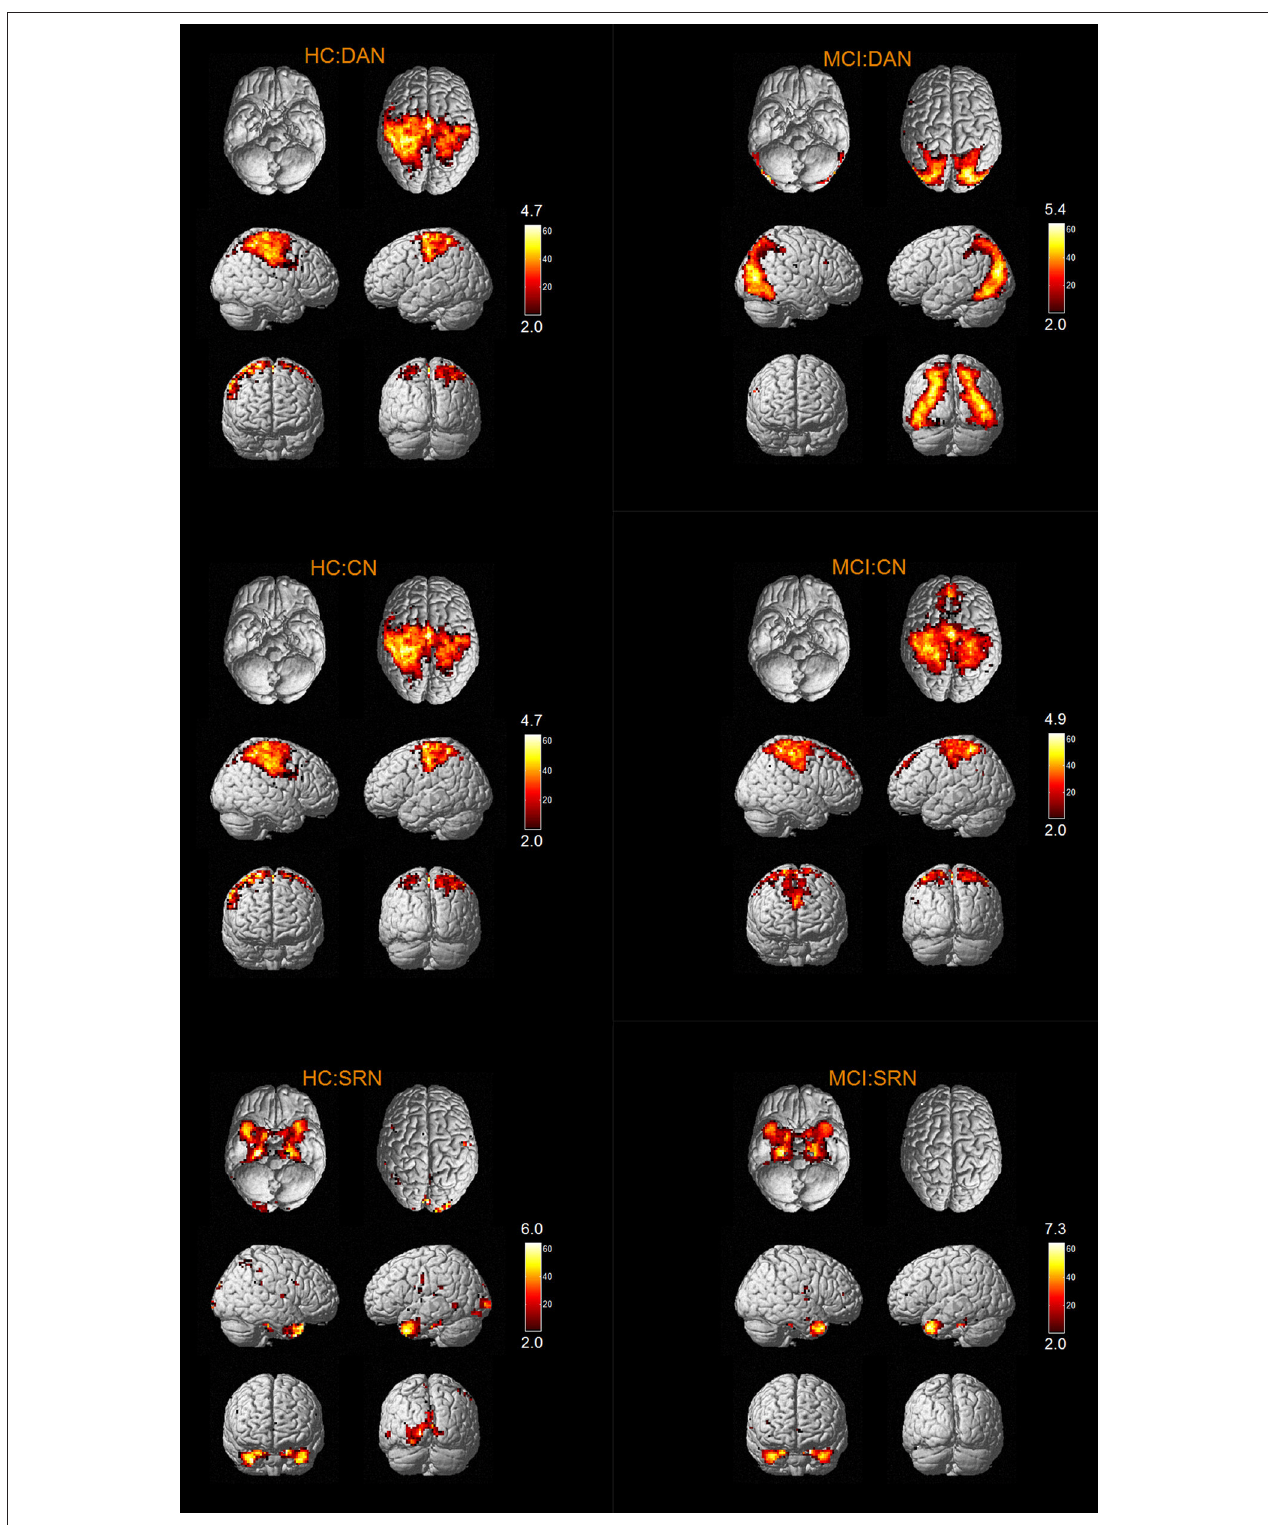
FIGURE 3 | The spatial distribution of CN, SRN in MCI group and HC group.